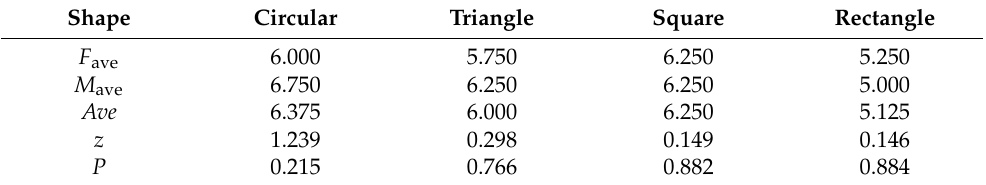
Table 4. Statistical analysis results showing that no significant gender differences exist in the ob- tained data. Shape Circular Triangle Square